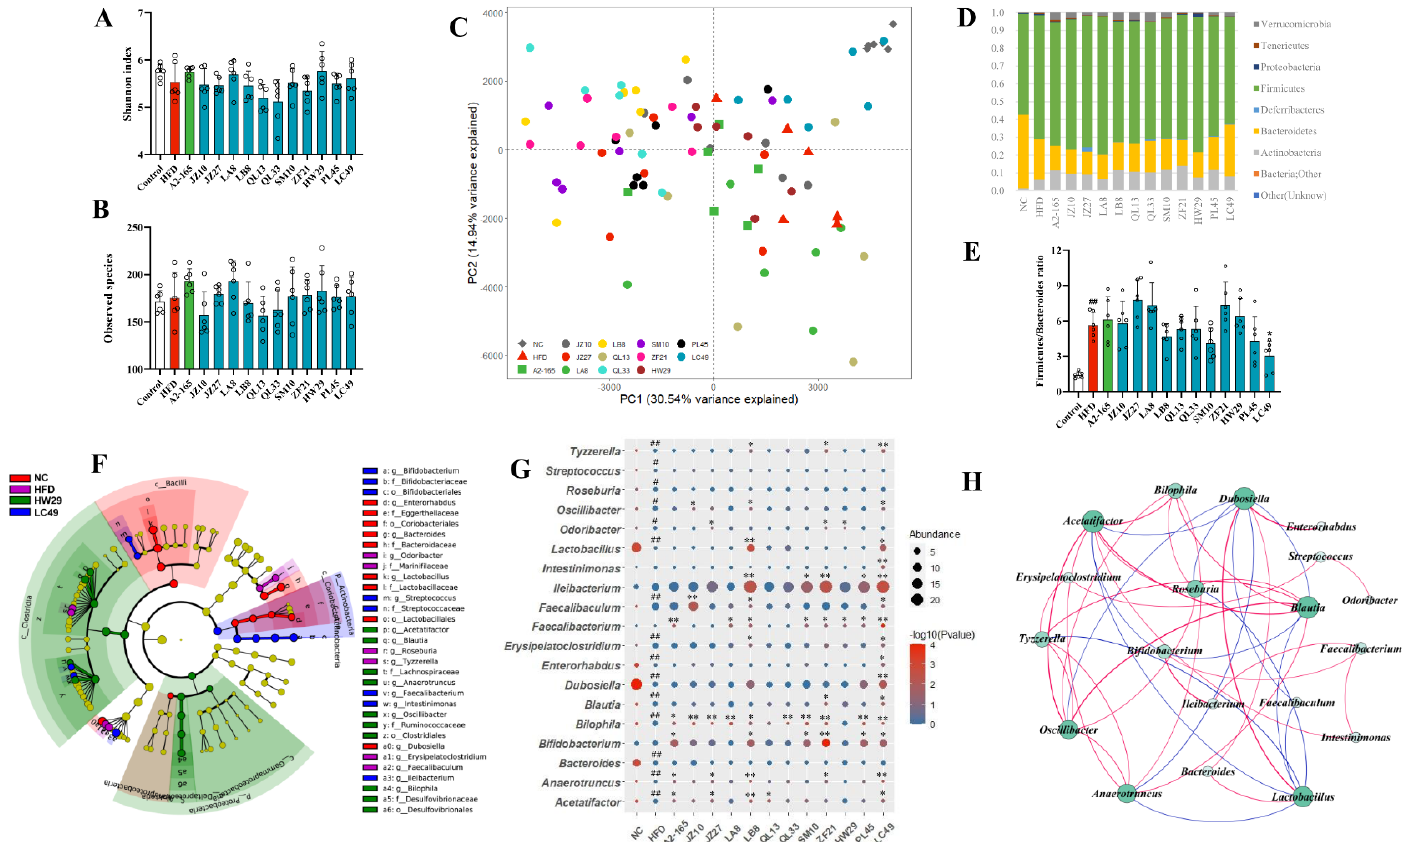
Figure 4. The effect of F. prausnitzii strains on gut microbial composition in NAFLD mice. ( A , B ) Shannon index and observed species; ( C ) Principal coordinates analysis; ( D ) Changes in the abundance of phylum level; ( E ) The ratio of Firmicute/Bacteroidetes; ( F ) Cladogram depicting the differentially abundant taxa (LDA score > 2 and p < 0.05) among all groups. The right panel presents the differential taxa labeled with various tags; ( G ) The relative abundance of taxa remarkedly changed by HFD feeding and F. prausnitzii treatment. The size and color of the circles display the average abundance and p value, respectively; ( H ) Interaction network analysis among microbial biomarkers. The circle size indicates the contribution, and the line color represents a positive (red) or negative correlation (blue), respectively ( p < 0.05, r > 0.3 or r < − 0.3). Data are shown as means with SD; # p < 0.05, ## p < 0.01 vs. NC group, unpaired Student’s t -test; * p < 0.05, ** p < 0.01 vs. HFD group, one-way ANOVA followed by Dunnett’s test.